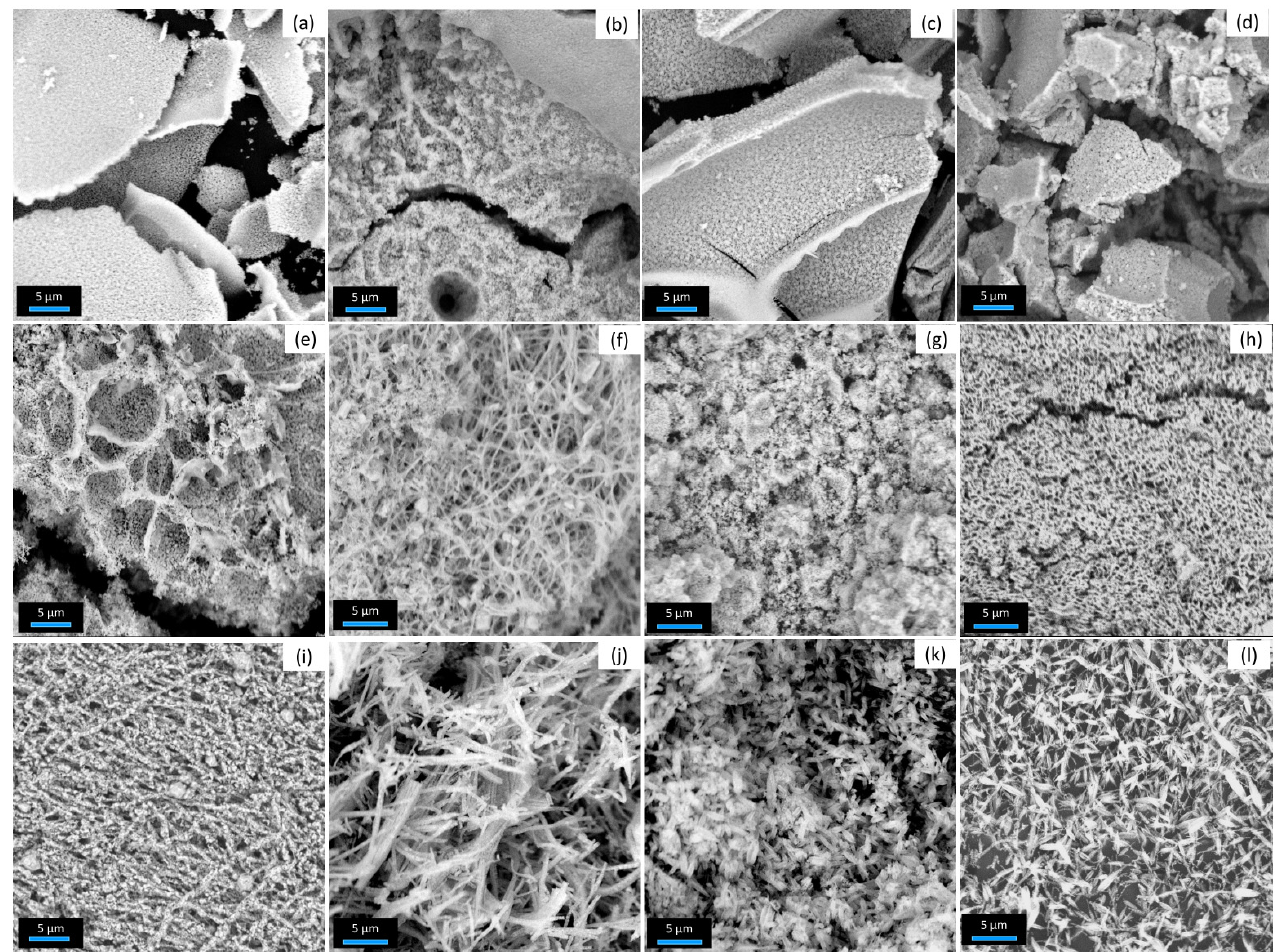
Figure 1. SEM micrographs of samples ( a ) 5MD-sg, ( b ) 5ME-sg, ( c ) 5MF-sg, ( d ) 5MK-sg, ( e ) 5MD-a,